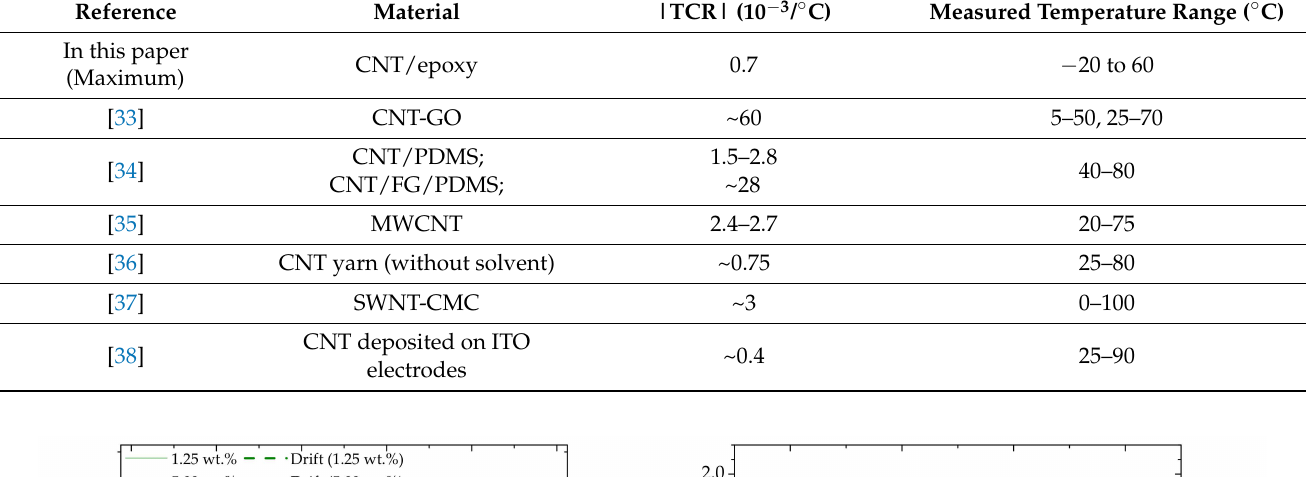
Table 1. Comparison of the TCR between our case and other types of temperature sensors.